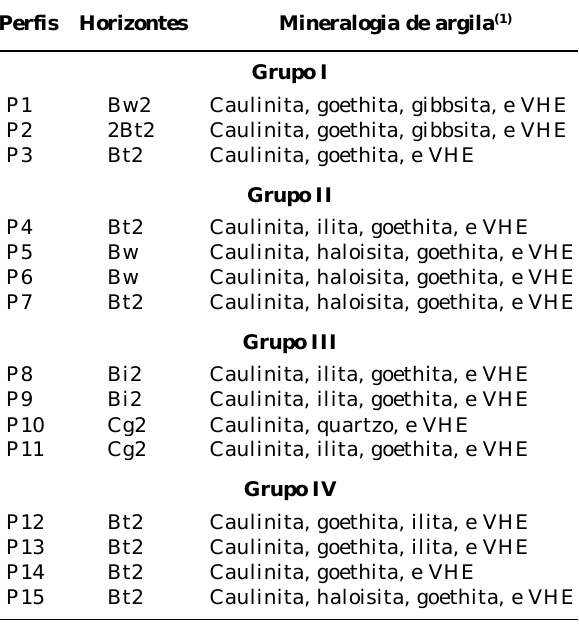
Figura 2. Curvas de distribuição da argila total em profundidade nos perfis desenvolvidos de rochas graníticas e